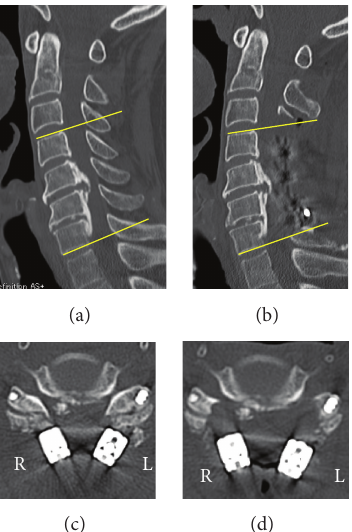
Figure 3: Pre- (a) and postoperative ((b) and (c)) and postadditional foraminotomy (d) computed tomography (CT). (a) and (b): lordosis angle at the operated segment (C4–7) increased by 5 degrees compared to the preoperative angle. (c): there were no changes in anteroposterior diameters of the bilateral C4/5 foramen and no malposition of the screws on postoperative CT. (d): Additional bilateral foraminotomy at C4/5 was performed.